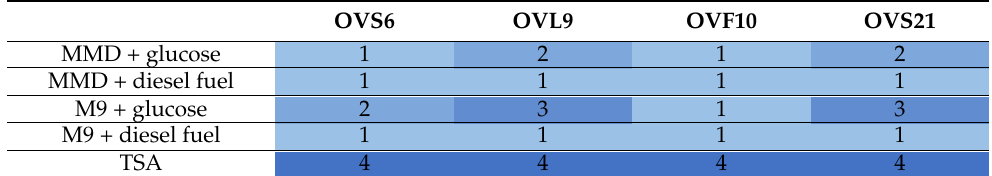
Table 3. Diesel fuel degrading potential of the endophytes on agar media. The values and the colors indicate different growth levels of the strains compared to the growth control, that is: complete (4), strong (3), intermediate (2), weak (1), absent